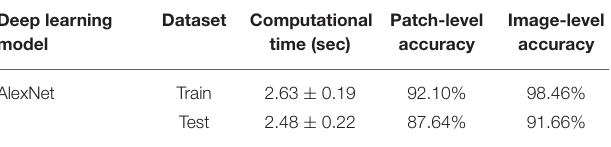
TABLE 3 | Performance of the proposed algorithm in canine RCT classification for train and test